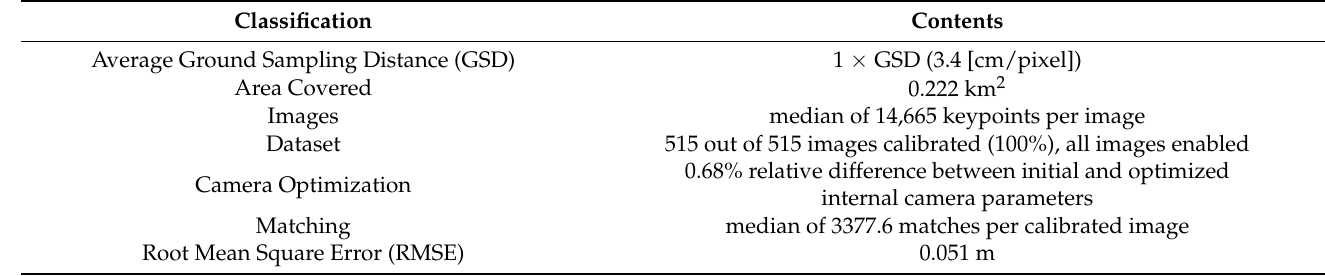
Table 5. Evaluation of quality characteristics of topographical data.